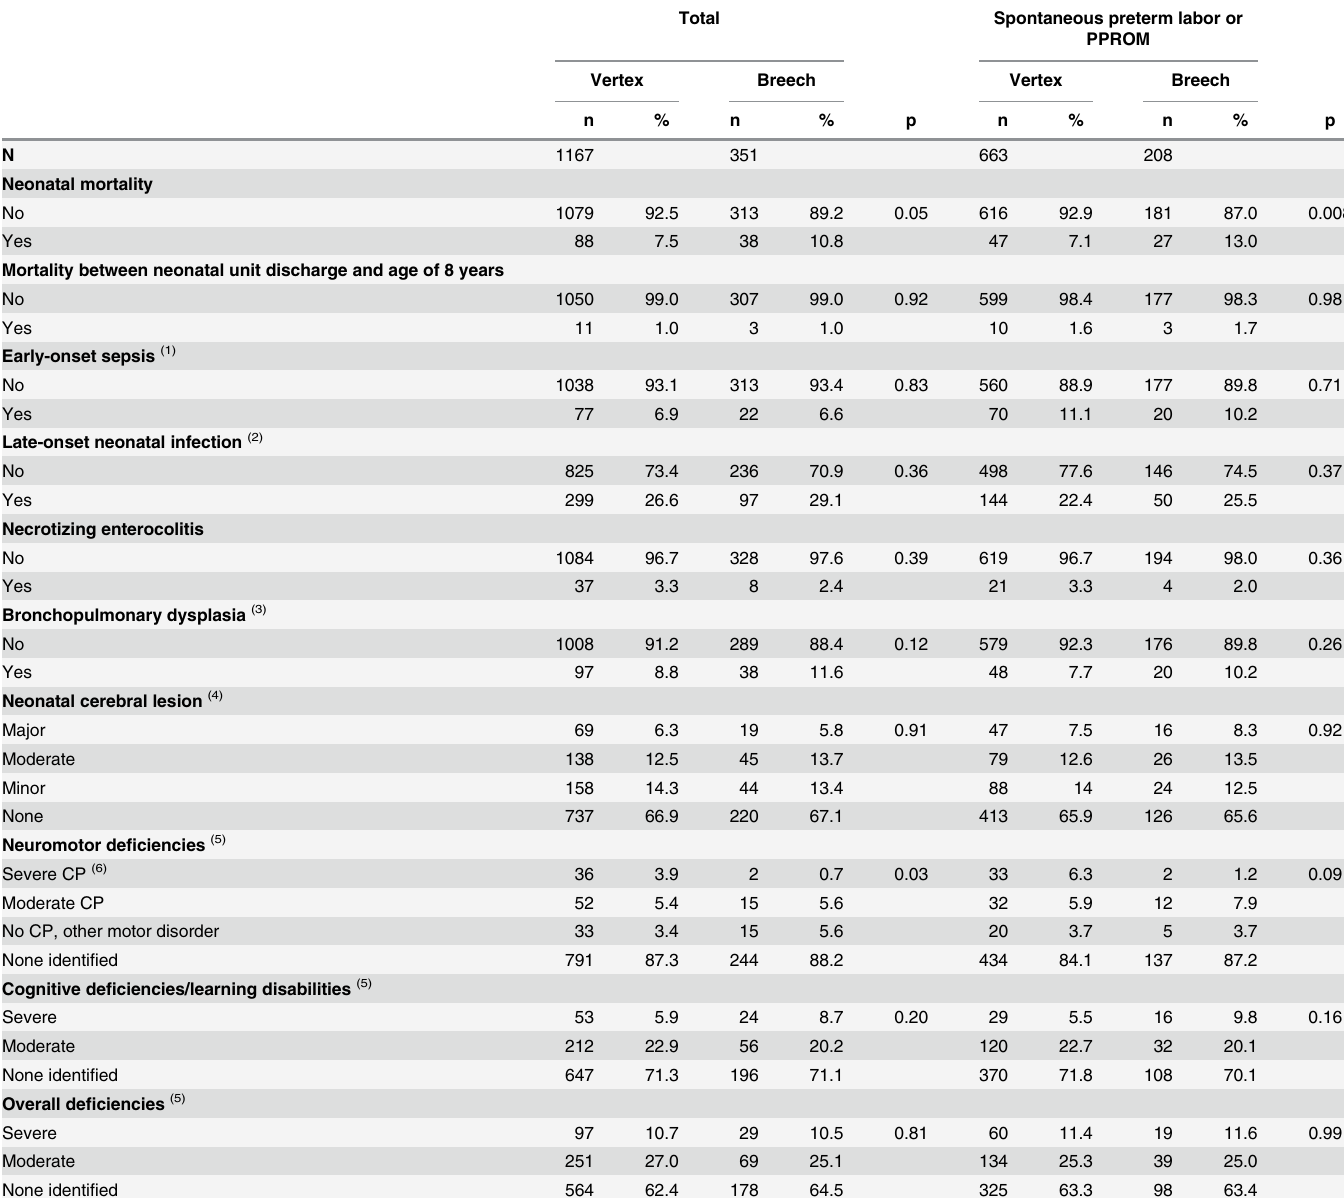
Table 4. Mortality, neonatal morbidity, and long term neurodevelopmental outcome according to fetal presentation.